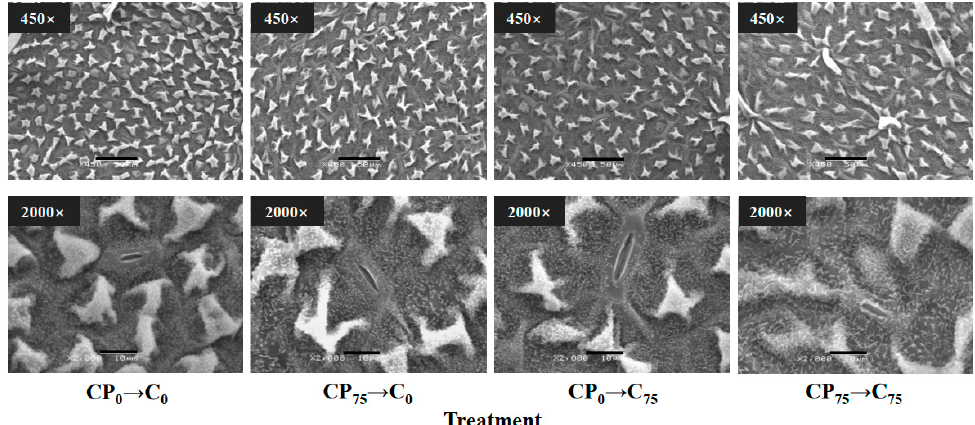
Figure 1. Leaf surface of cutting-propagated poinsettia subjected to a high temperature stress. Si 0 , 0 mg · L − 1 Si; Si 75 , 75 mg · L − 1 Si.